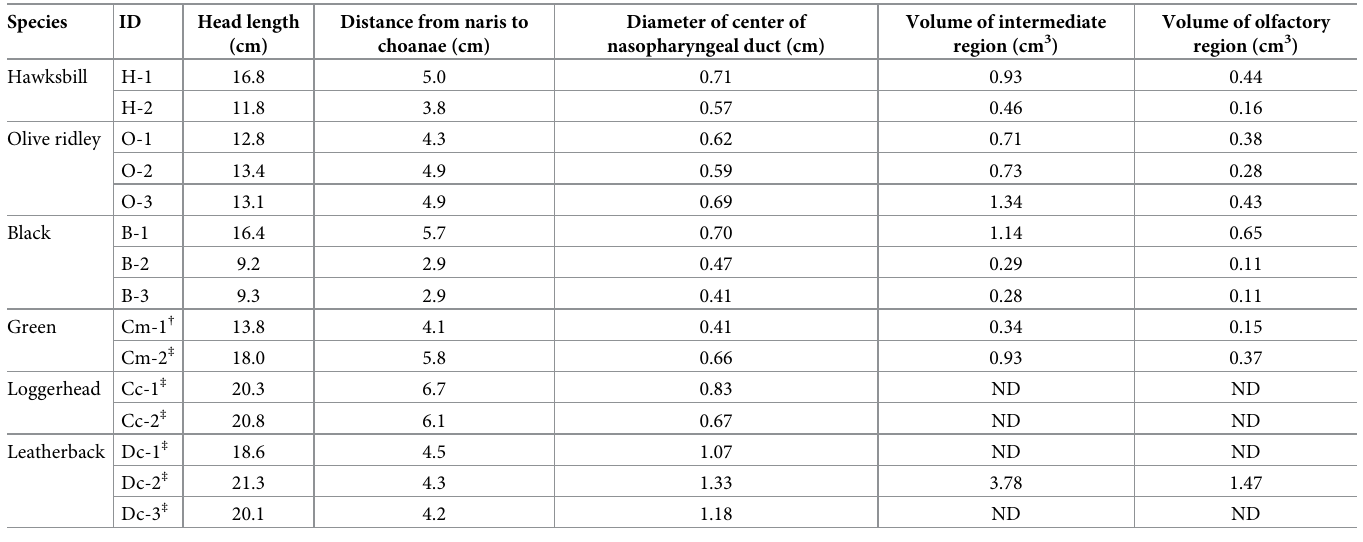
Table 2. Measurements of left half of nasal structure. Species